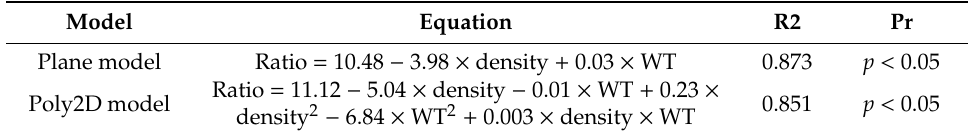
Table 5. Applied regression models for estimate the influence of WT and soil density on the ratio of Proteobacteria to